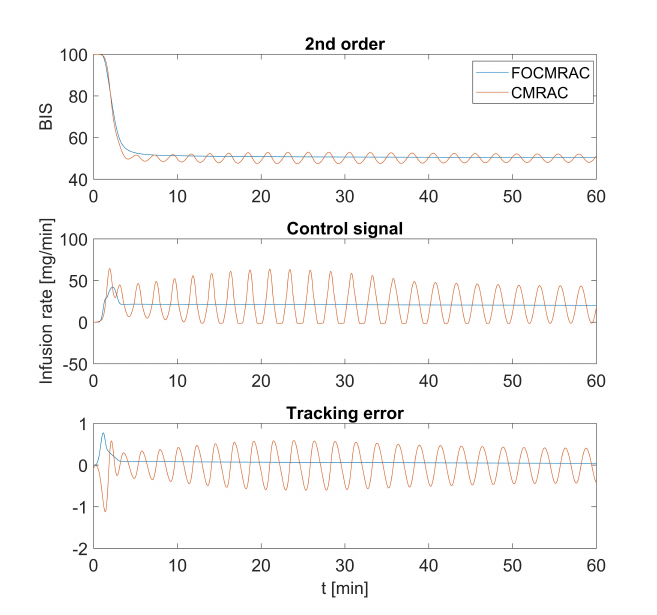
Figure 27. Comparison between the 2nd-order FOCMRAC and the CMRAC, BIS output, control signal, and tracking error.